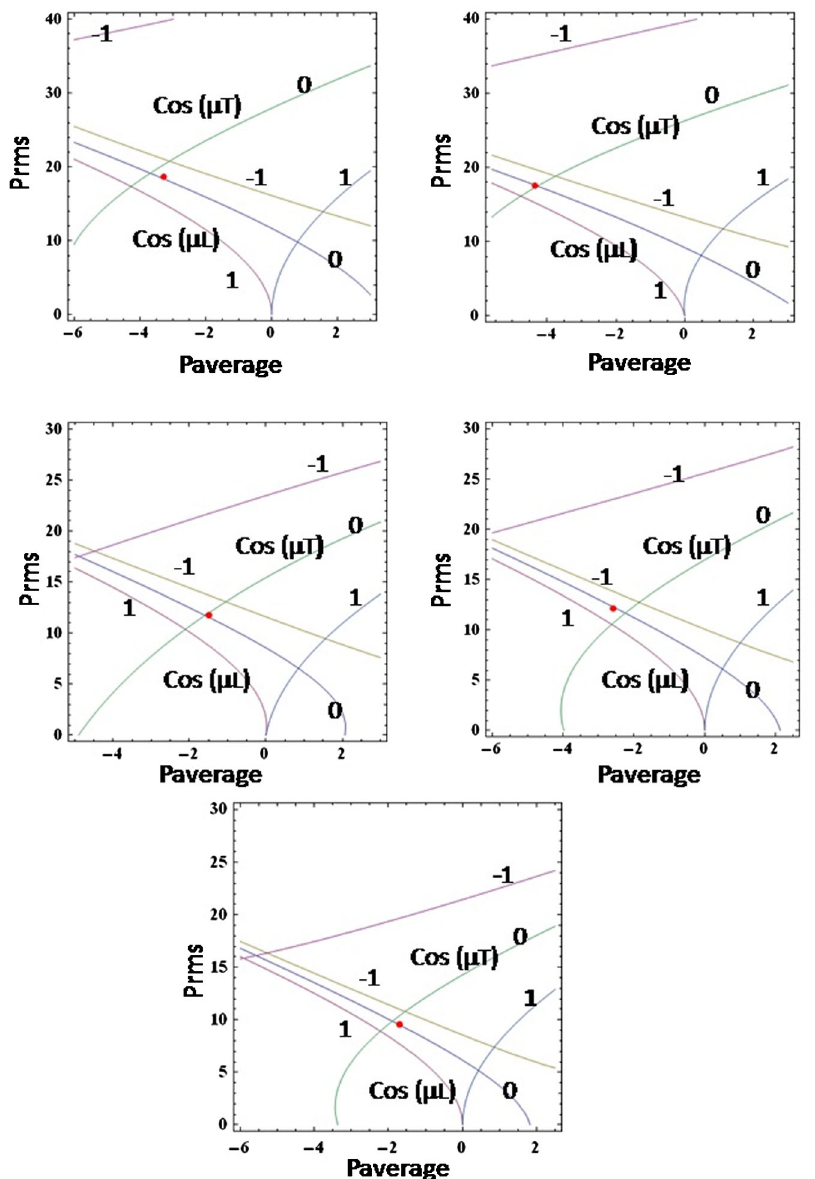
FIG. 3. Neck-tie stability diagram for five focusing periods, with red points showing the position of operating